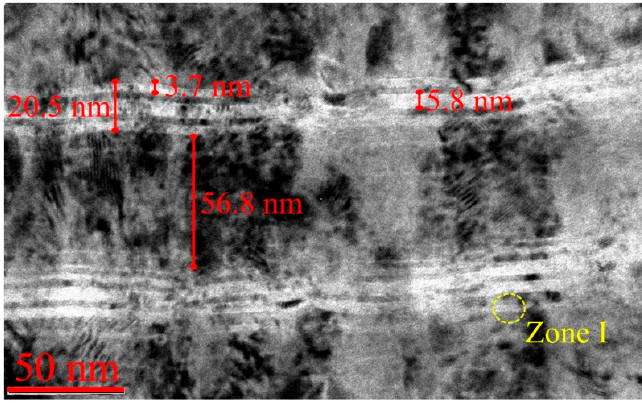
Figure 6. Nano-structure of the wear-resistant (Ti,Al,Si)N layer of the coating (at S4) (TEM).